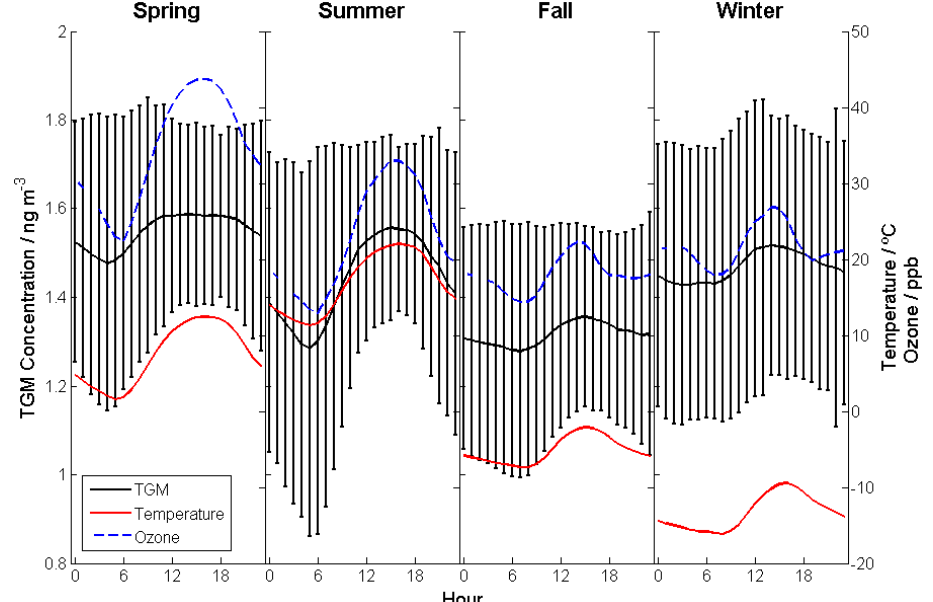
Figure 3. Seasonal diel profiles of mean TGM concentrations at Patricia McInnes station after removing data impacted by forest fire smoke. Seasonal diel profiles of mean temperatures and ozone concentrations at Patricia McInnes are also shown for reference Vertical bars indicate ± 2 standard deviations of TGM concentration data at each